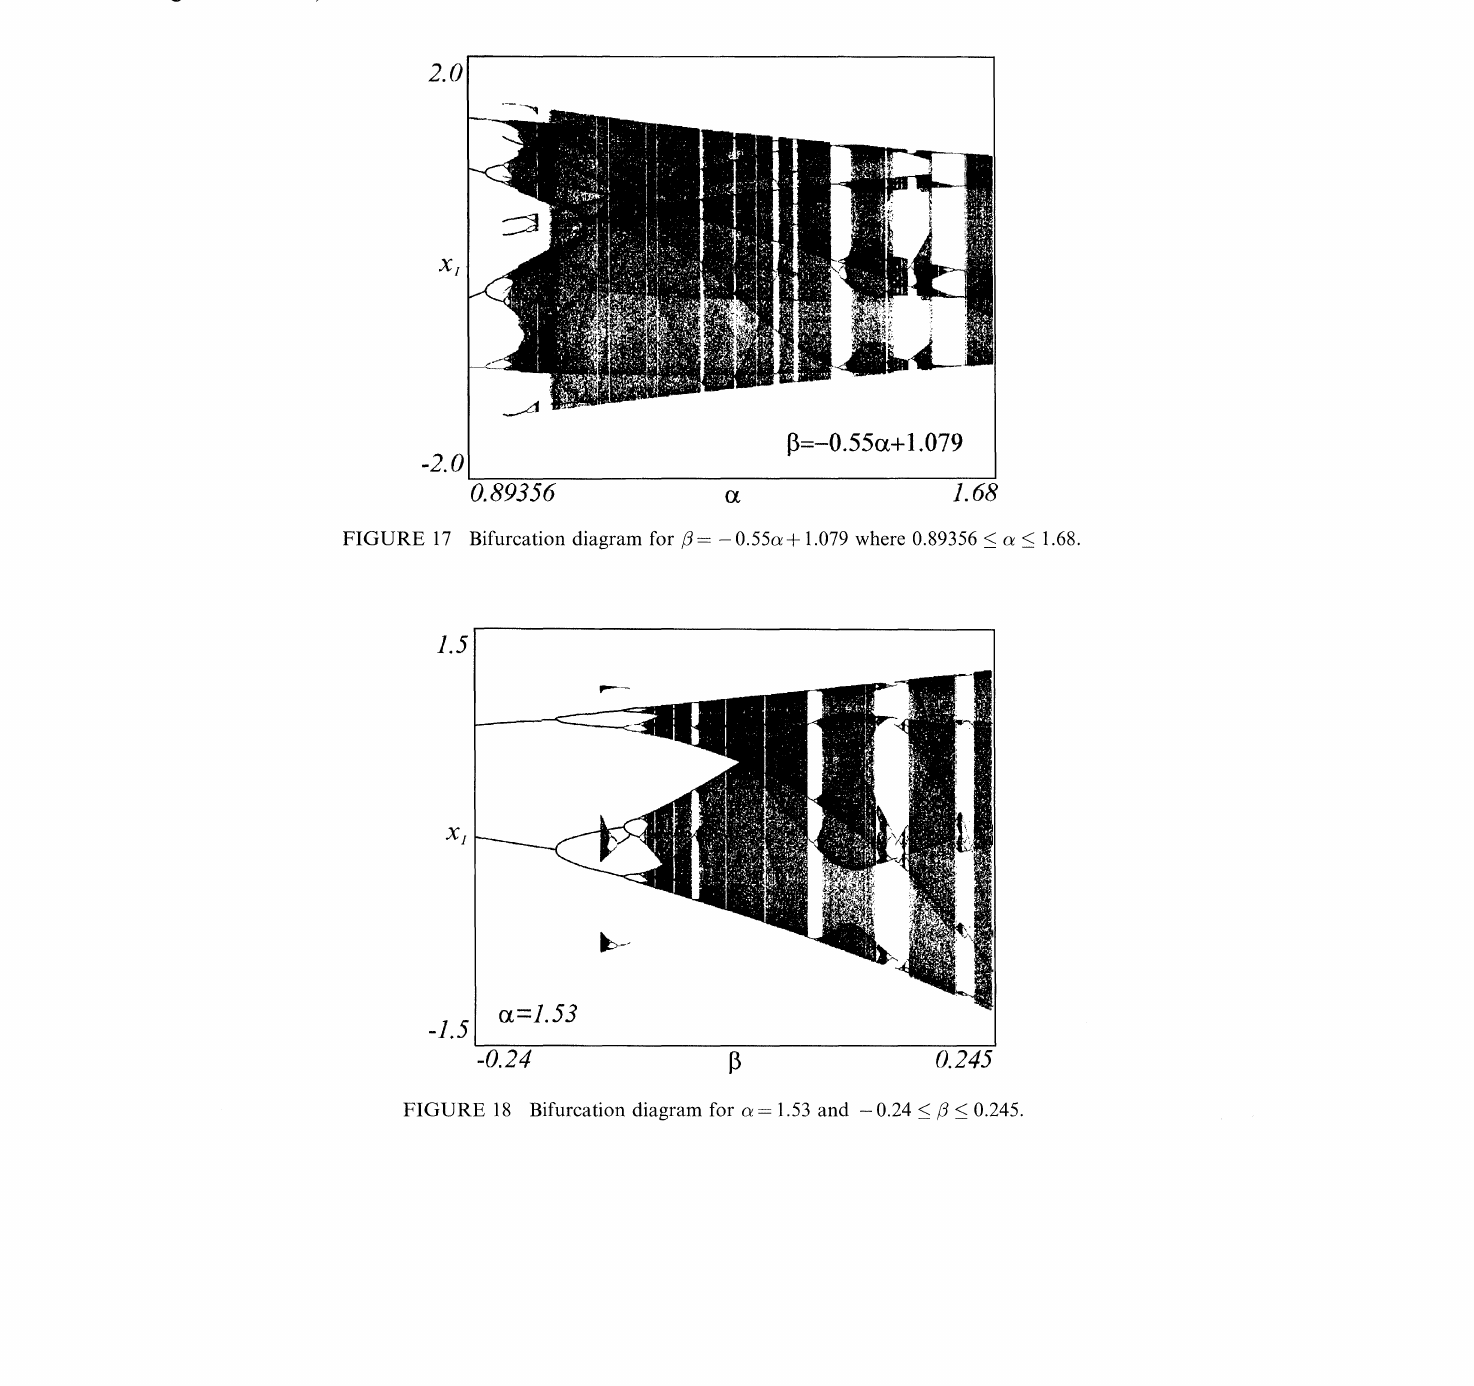
FIGURE 17 Bifurcation diagram for/3= -0.55c+ 1.079 where 0.89356 _< c < 1.68.